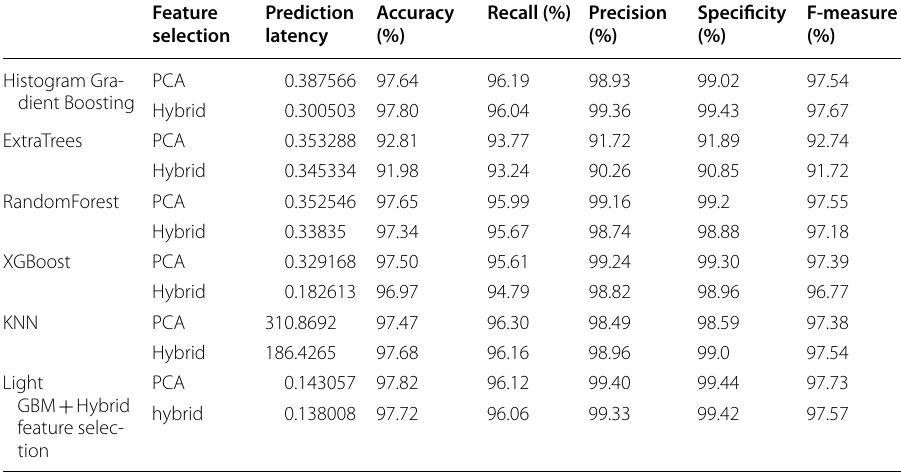
Table 10 Comparison of the Proposed model with other machine learning algorithms Feature